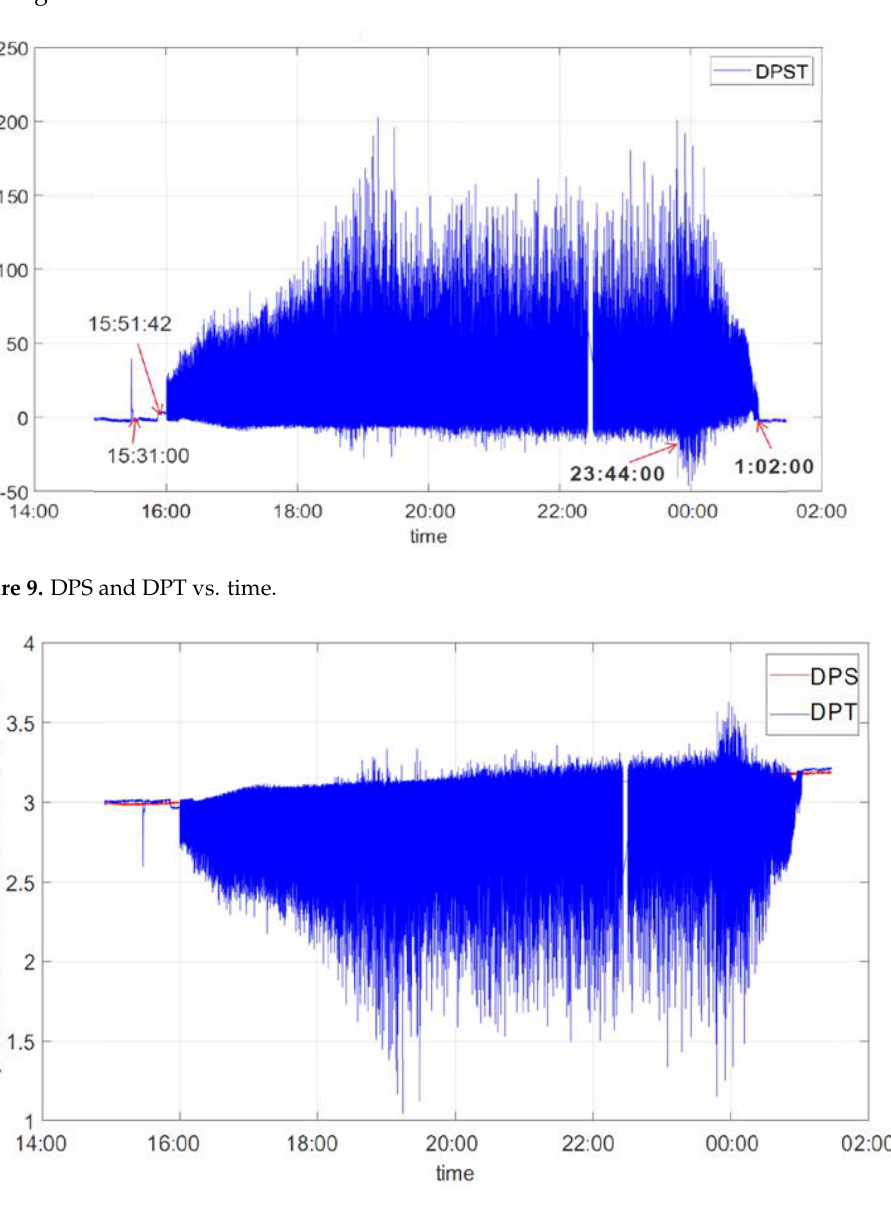
Figure 11. Smooth stratified flow upstream of the orifice. Figure 12. Stratified wavy flow upstream of the orifice.